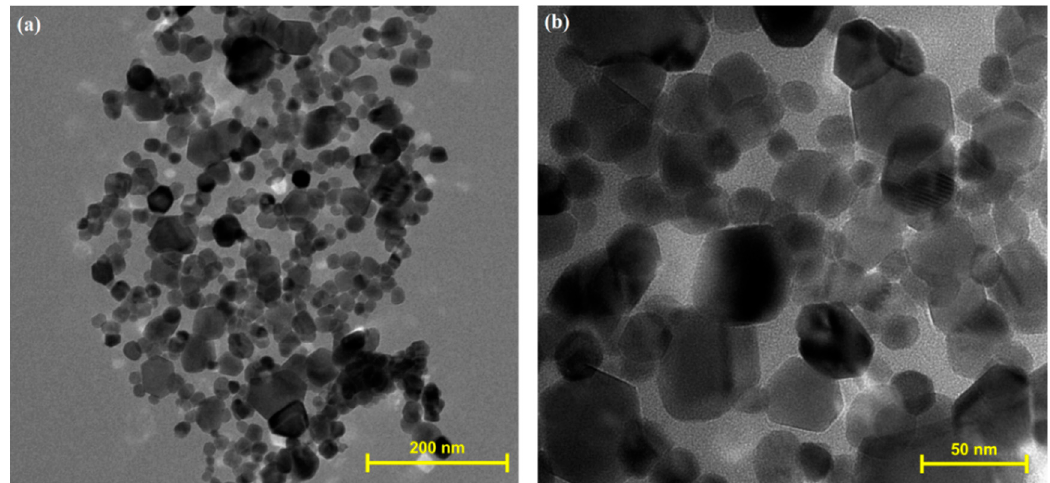
Figure 2. Transmission electron microscope (TEM) micrographs of nanocrystalline building blocks on sample ( a ) S5 × 350 k; ( b ) × 1300 k.